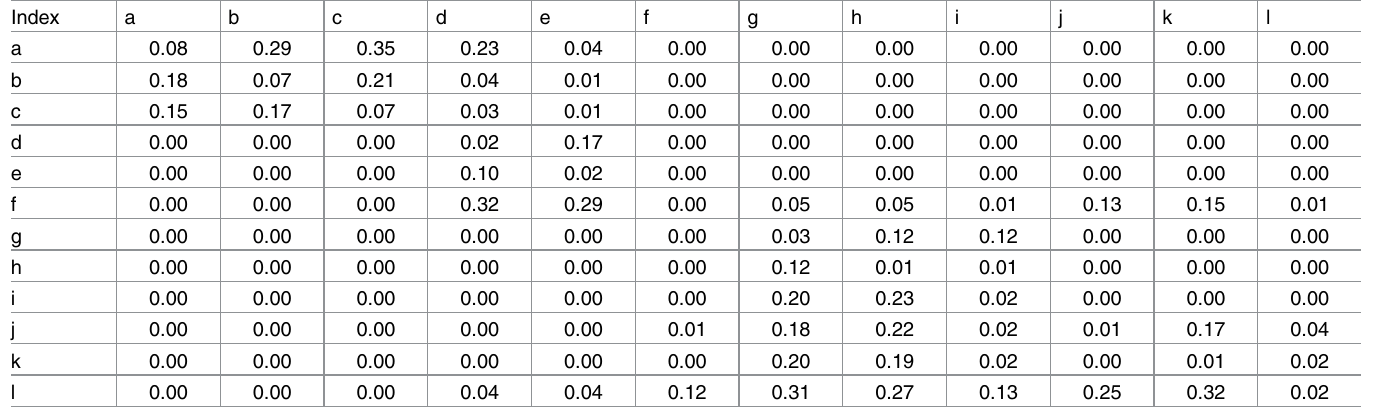
Table 4. Total-relation matrix T .